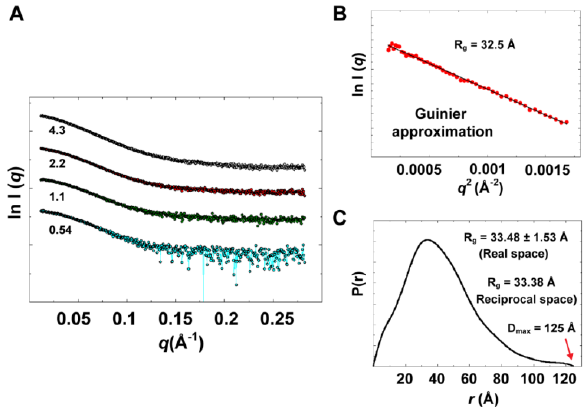
optimal with χ values of 1.9 and 2.9 for the crystal structure and the average MD structure, respectively (Figure 10C). This was interpreted to mean that no single conformation can satisfactorily fit the scattering data.